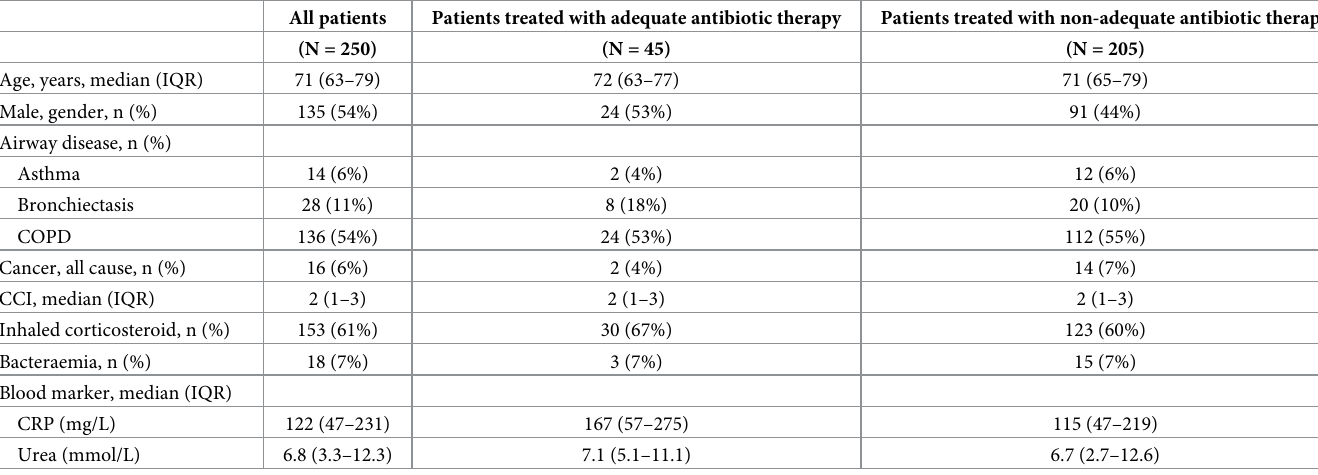
Table 1. Patient characteristics of the study